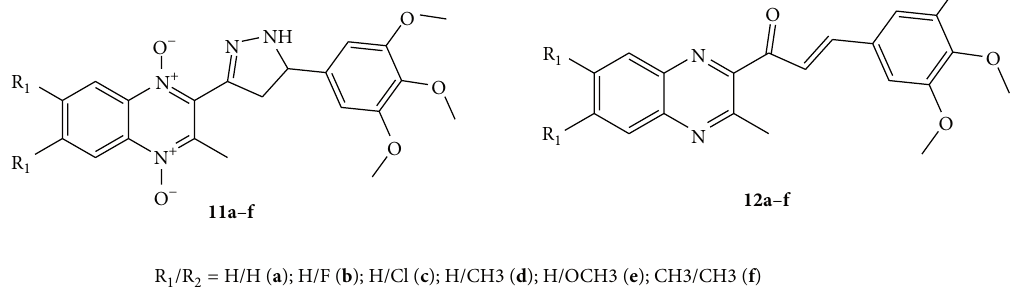
Figure 5: Chemical structures of compounds tested.